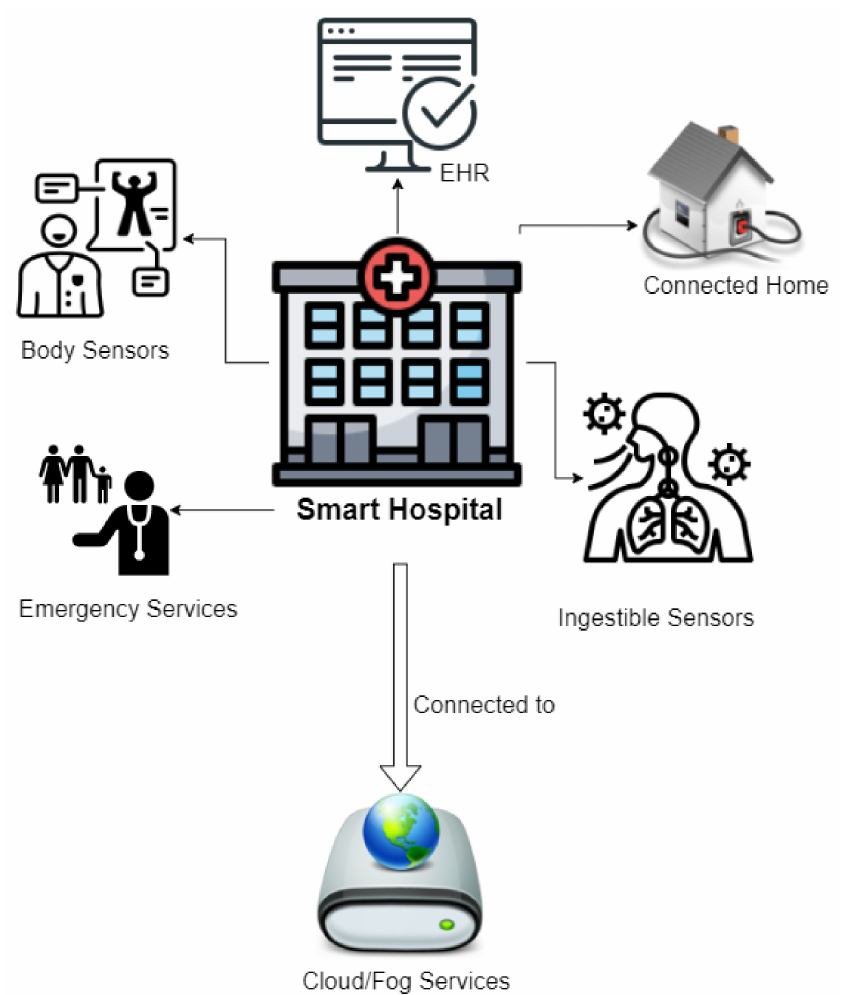
Figure 1. An outlook of IoT-assisted hospitals for healthcare